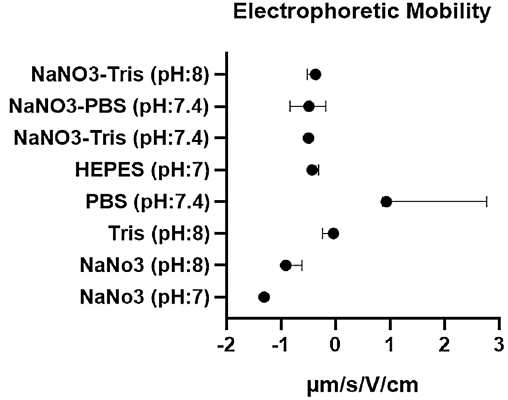
Figure 3. Electrophoretic mobility (µ) of MS2 VLPs in different solutions and buffers. µ value of MS2 VLPs was negative in all solutions and buffers except the VLPs in PBS (pH:7.4). Samples were diluted at 1:10 in selected buffers and solutions. Data were shown as median with